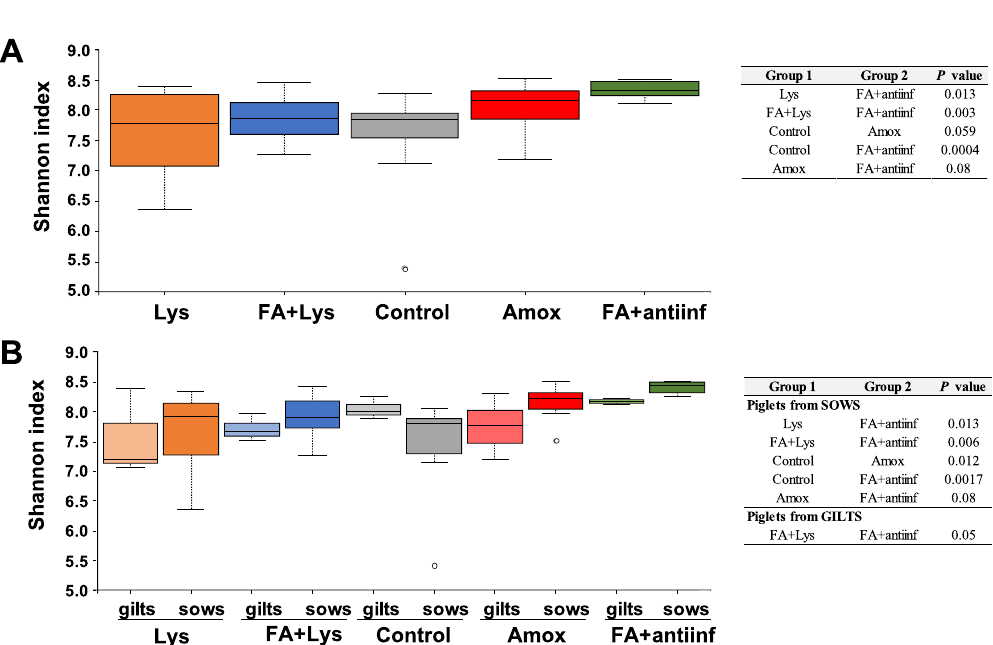
Figure 4. Alpha diversity from nasal microbiota is different depending on the treatment group. Diversity was estimated using Shannon’s index at D21 on nasal samples for the treatment groups ( A ) or considering the parity of the dams ( B ). The dotted lines represent standard deviation and outliers are indicated with white circles. The alpha significance is shown in the right panel indicating the P values, when significant. The treatment groups were: Lys lysozyme, FA + lys medium chain fatty acids and lysozyme, C control, with no additives, Amox amoxicillin, FA + antiinf medium chain fatty acids and a natural anti-inflammatory; each group was splitted according the parity of their dams: gilts (first delivery) or sows (more than 1